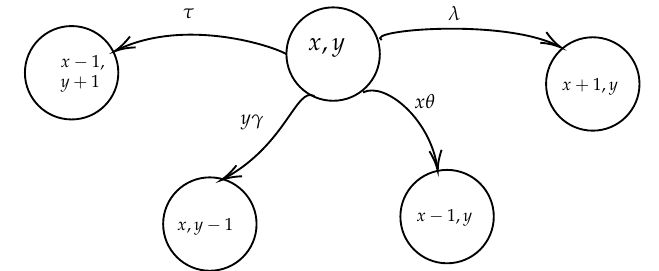
Figure 4. Markov chain of the basic P2P